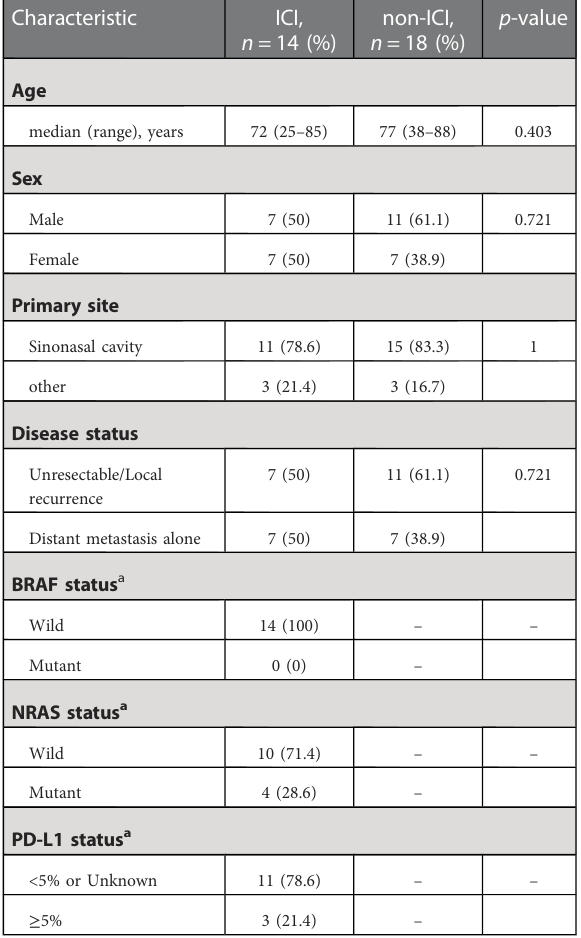
TABLE 1 Background comparison between ICI and non-ICI groups in patients with advanced HNMM. Characteristic